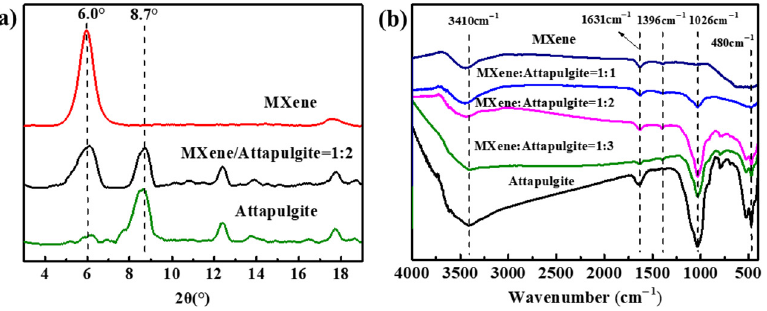
Figure 2. ( a ) XRD results and ( b ) FTIR spectra of attapulgite, MXene and the MXene/attapulgite